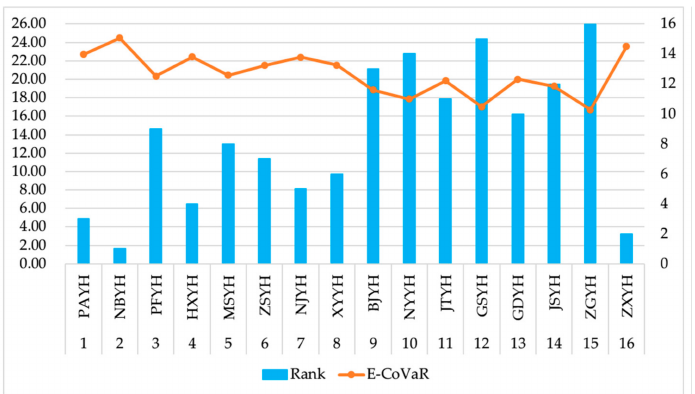
Figure 16. Measurements and rankings of Exposure ∆ CoVaRs (The left axis and right axis refers to the value and ranking of the Exposure ∆ CoVaR (the di ff erence between the Exposure Conditional Value at Risk (CoVaRs) when the banking system is in distress and in a normal state) of each bank during the entire sample period) (overall analysis, exposure model).